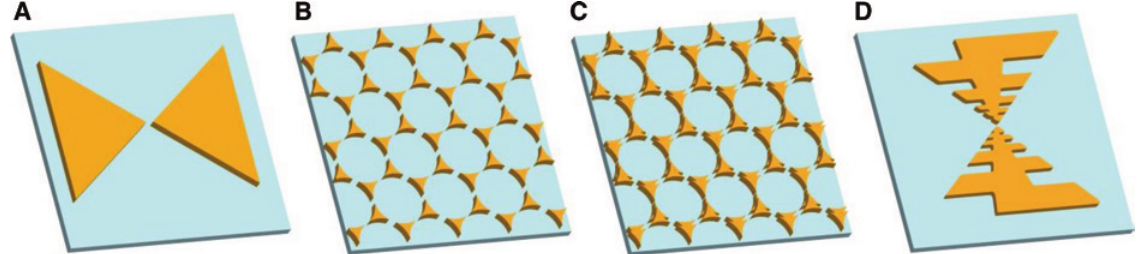
Figure 10: Various structures using